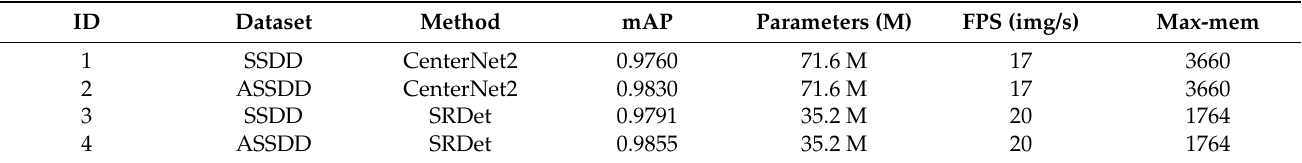
Table 5. Comparison of different